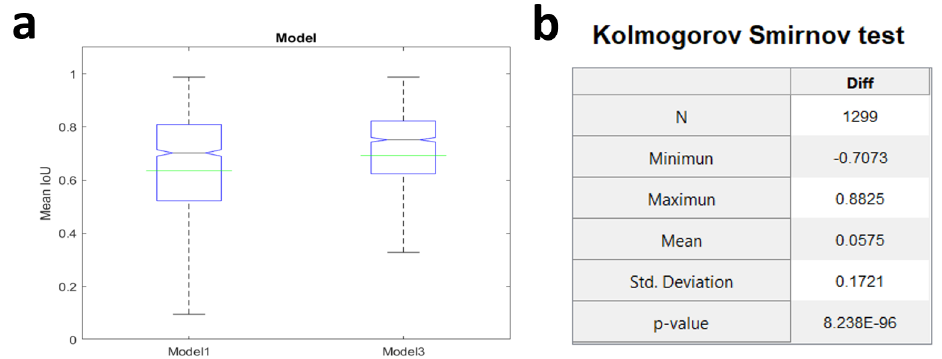
Figure A1. Box plot and normality test of the difference of both models. ( a ) Box plot, green line indi- cates the mean in both graphs, and gray line indicates the median. Model1, N = 1299, mean = 0.6358, median = 0.7027, std. deviation = 0.2289, variance = 0.0540. Model3, N = 1299, mean = 0.6933, median = 0.7517, std. deviation = 0.1940, variance = 0.0376. ( b ) Normality test on the difference of